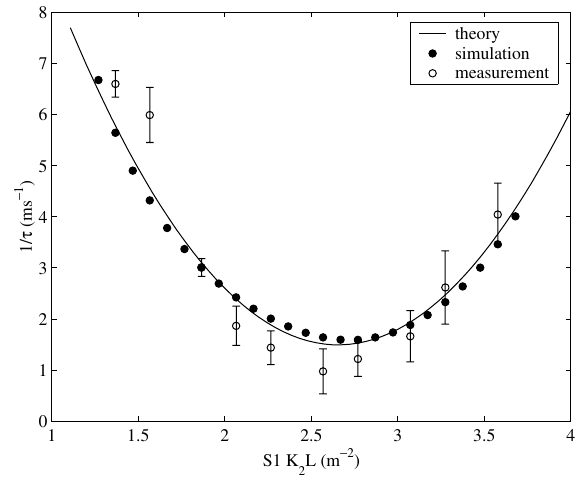
FIG. 3. Damping rate versus harmonic sextupole